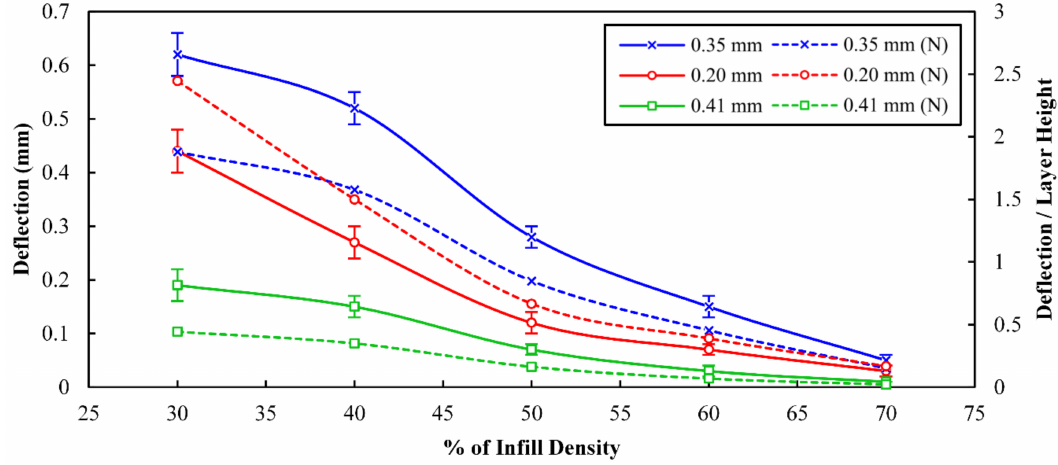
Figure 8. Deflection (solid lines) and normalized (N) deflection (dashed lines) of silicone in the gap of support structure versus infill density of the support structure for different nozzle sizes of 0.2, 0.35, and 0.41